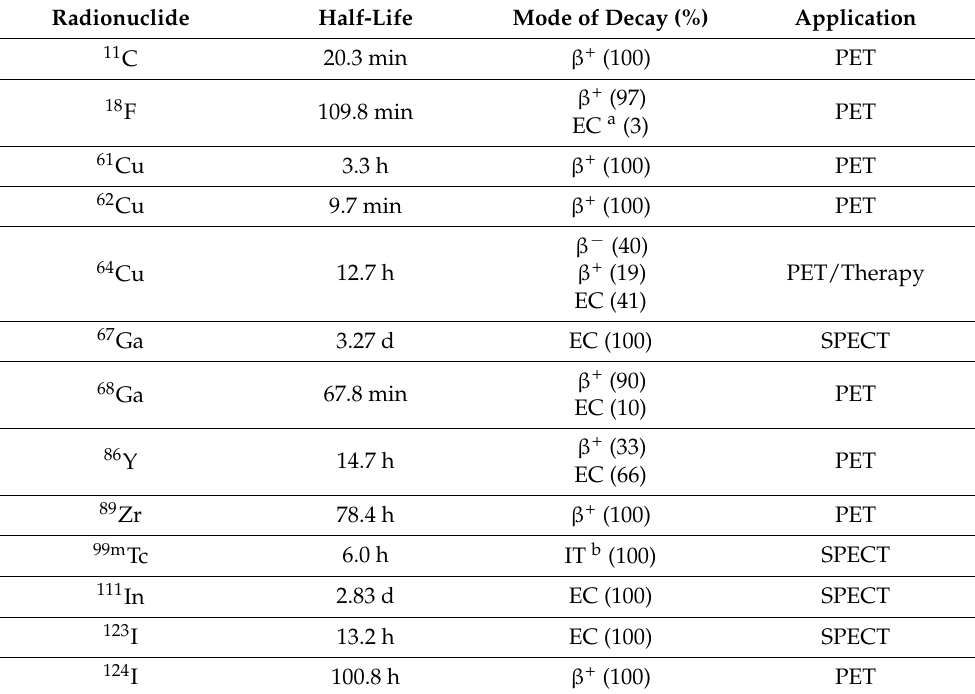
Table 1. Examples of Relevant Radionuclides for Imaging